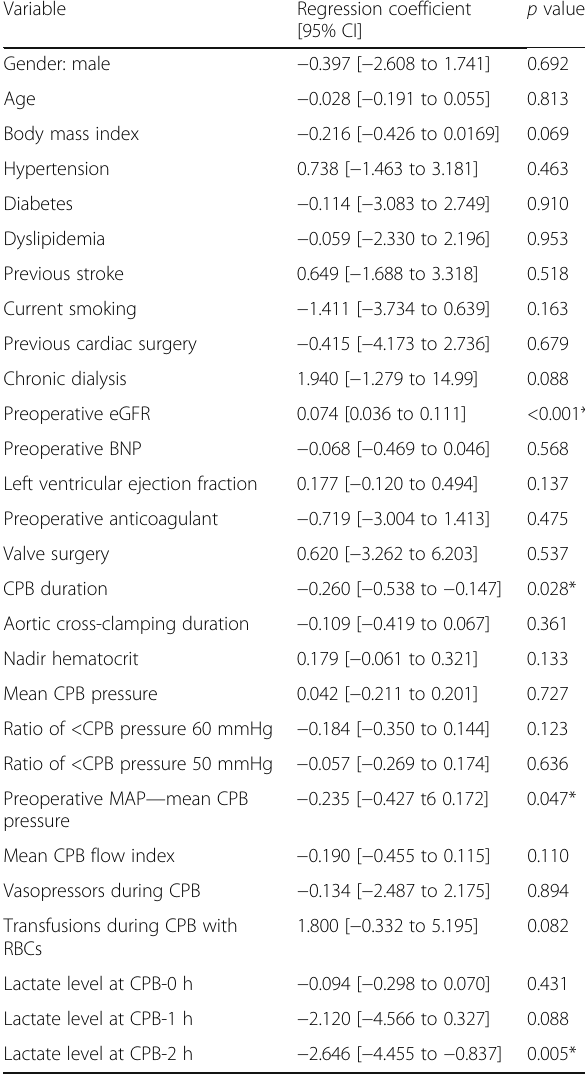
Table 3 Univariate association of preoperative and intra- operative variables with the ICU-free survival days Variable